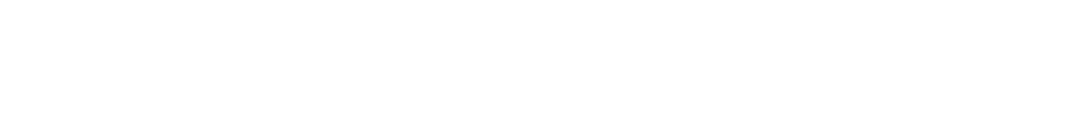
FIGURE 2 | Difficulty scores in 10 randomly selected cases, rated by 3 observers .The mean value of the three observers is also